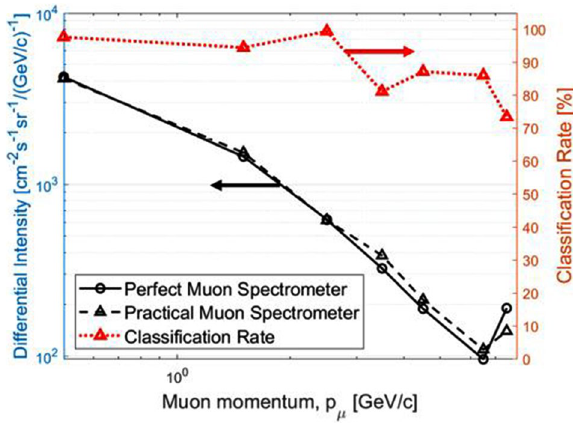
Figure 6. Reconstructed comic ray muon spectra. Reconstructed cosmic ray muon spectra are reconstructed using 10 4 muon samples with (i) perfect and (ii) practical muon spectrometers. Differential muon intensity increases and classification rate decreases at > 5.0 GeV/c because all muons that have a momentum greater than 5.0 GeV/c are categorized in the largest p th level. The computed classification rates for measurement classes are also indicated.